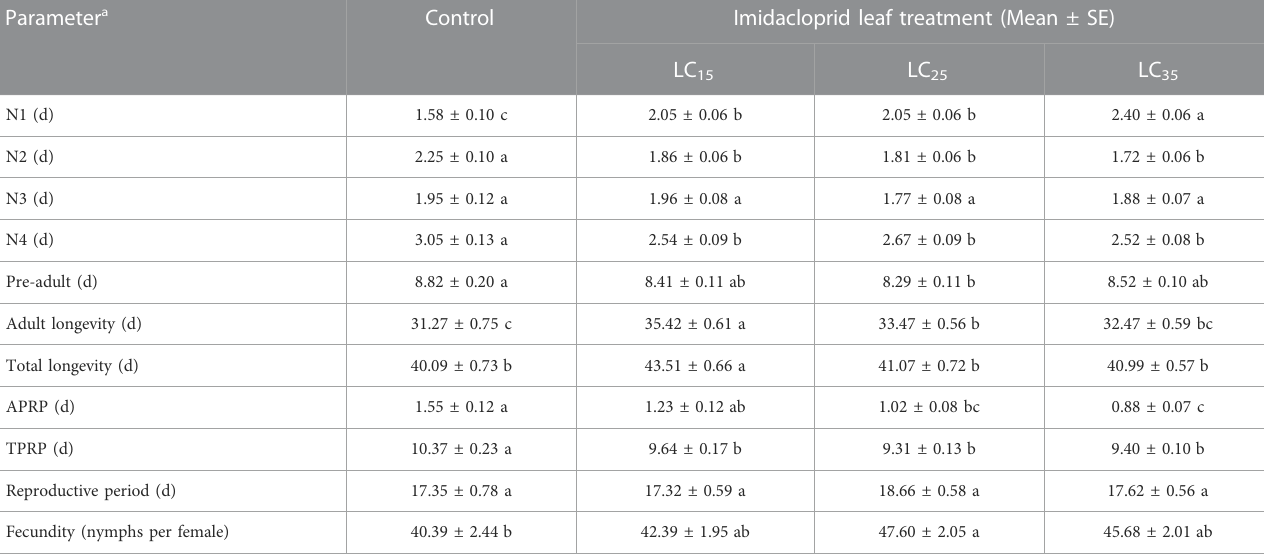
TABLE 1 The sub-lethal effects of imidacloprid on developmental duration and fecundity of the F 1 generation of Metopolophium dirhodum . Parameter a